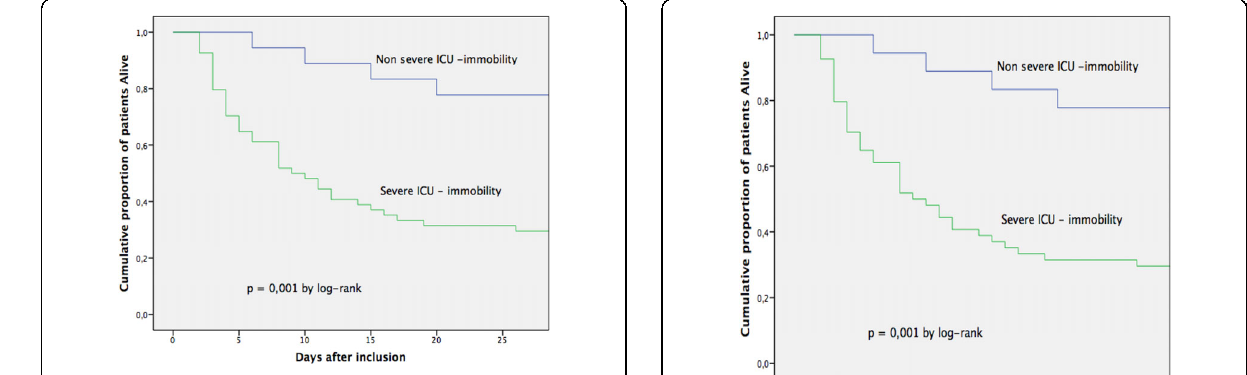
Fig. 2 (abstract 000926). See text for description